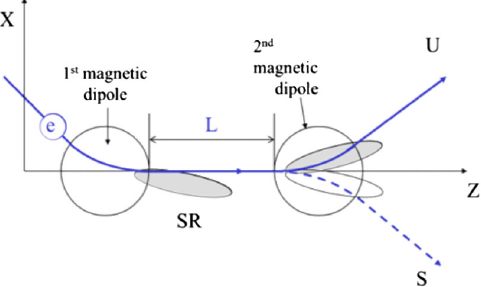
FIG. 1. Geometries for generation of synchrotron radiation from two magnetic dipoles in a U or an S